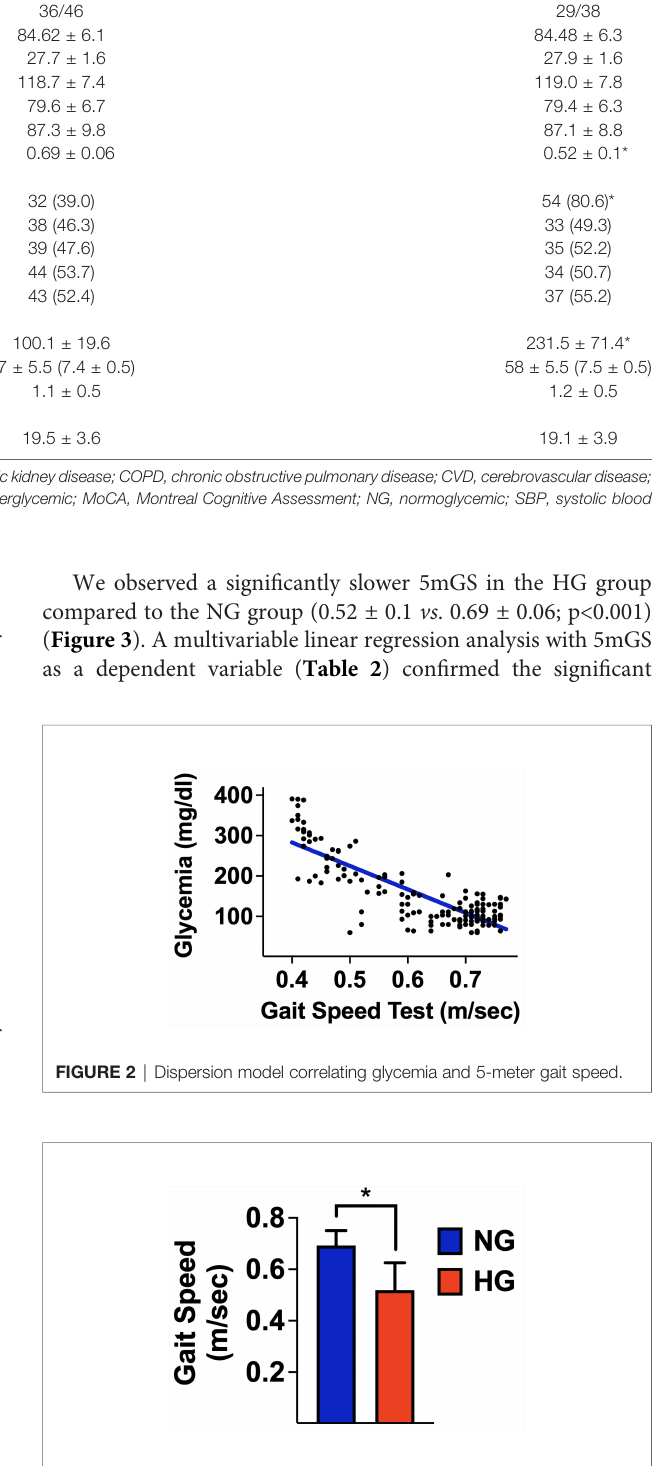
FIGURE 3 | Gait speed measured in normoglycemic (NG) and hyperglycemic (HG) patients; mean±SD; *p <